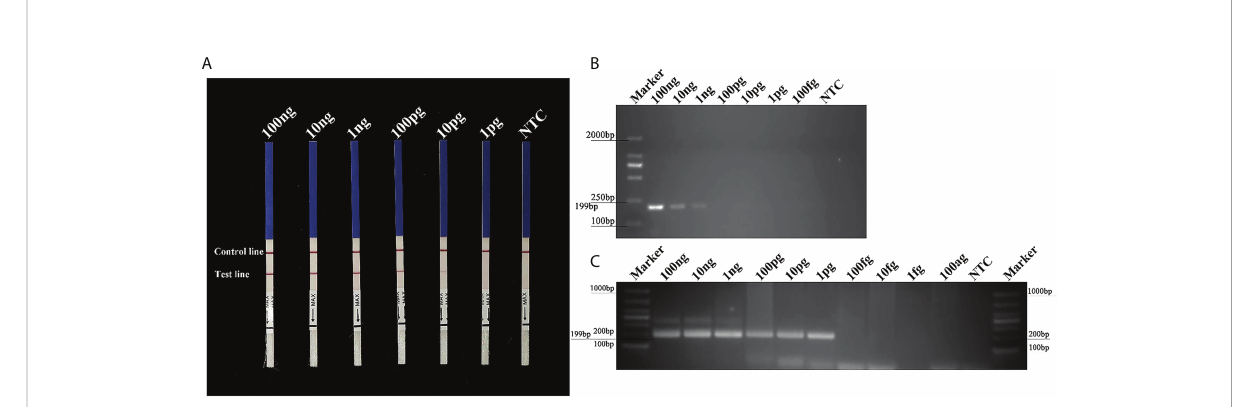
FIGURE 4 Sensitivity of the Pcinn13739 -RPA-LFD, conventional PCR and nested PCR assays for P. cinnamomi . (A) All dipsticks yielded visible control lines, indicating that the test was valid. Test lines were visible on LFDs of RPA reactions (50 µl) containing at least 0.01 ng (10 pg) of P. cinnamomi gDNA. (B) In the conventional PCR assay, the detection threshold was 1 ng. No PCR amplicons were detected in reactions containing DNA template at 0.1 ng or lower. NTC, negative control. Marker DL2000 (Takara Shuzo, Shiga, Japan). (C) Nested PCR assay could detect 1 pg gDNA of P. cinnamomi , yielding positive detection results. NTC, negative control. Marker DL1000 (Takara Shuzo, Shiga, Japan). Experiments were repeated three times; all replicates showed the same